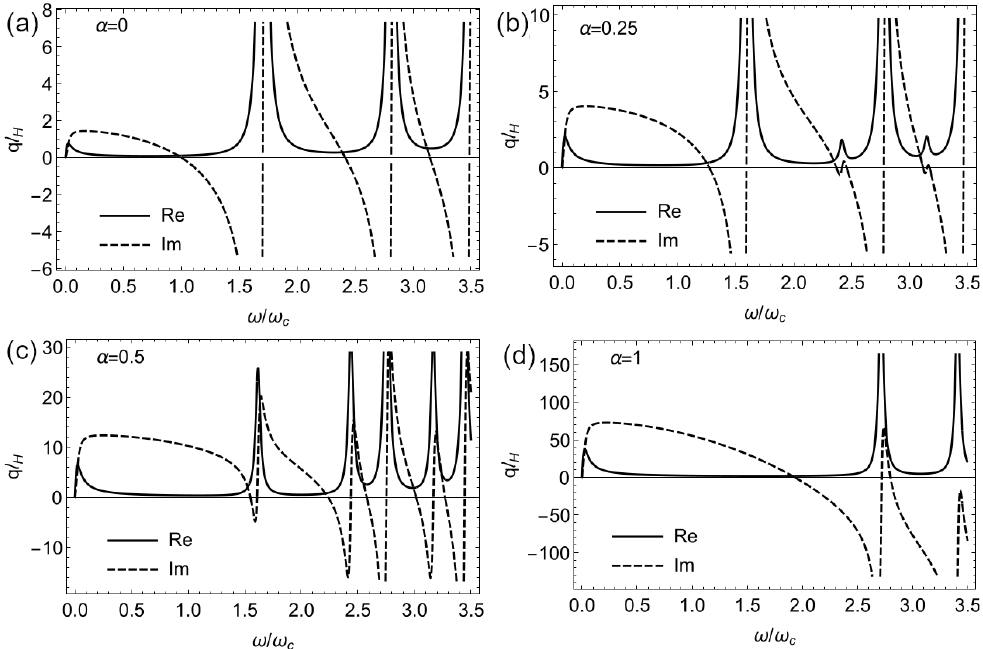
Figure 10. Real and imaginary parts of the wavevector for TM plasmons in the long wavelength approximation for µ = 0, ( a ) α = 0, ( b ) α = 0.25 and ( c ) α = 0.5 and ( d ) α = 1. Setting σ xy = 0 has no effect on the dispersion due to the inherited isotropy of the